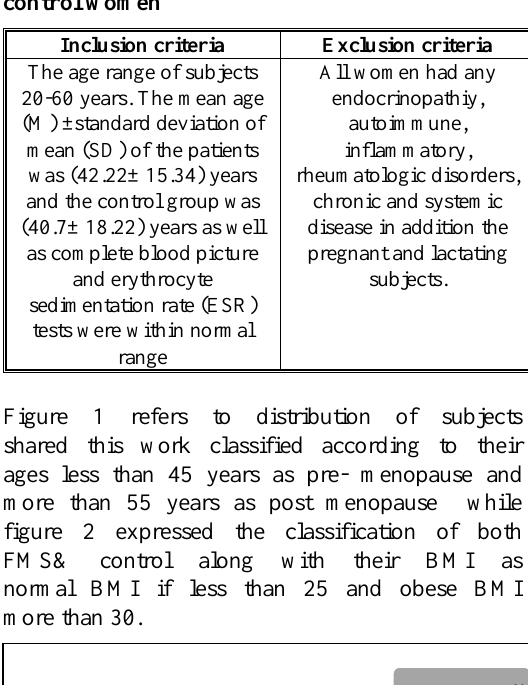
Table 1. the selection criteria for FMS and